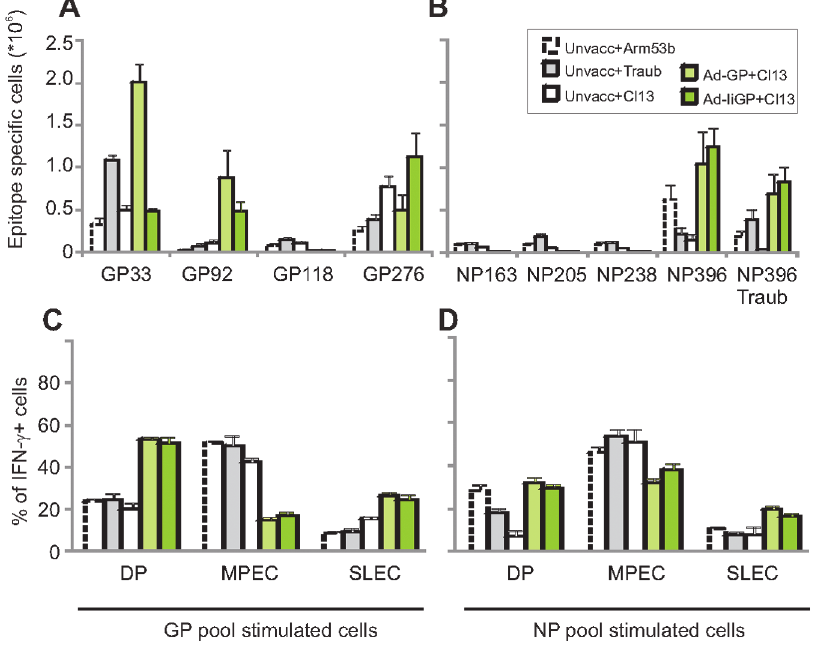
Fig 4. Comparison of vaccine attenuated Cl13 infection and primary infection with Cl13, Armstrong 53b or Traub strain of LCMV on the generation of memory CD8+ T cells. Cells from mice infected as indicated or vaccinated as indicated and then clone 13 challenged were stimulated with individual GP or NP peptides ( a-b ), or with a pool of GP ( c ) and NP ( d ) peptides 150 days after infection. The total number of splenic CD8+ T cells producing interferon- γ is shown in a-b . The percentage of cell producing interferon- γ in response to GP ( c ) or NP ( d ) peptides, that also expressed certain combinations of CD127 and KLRG-1 are depicted, CD127+/KLRG1+ (DP), CD127+/KLRG1- (MPEC) and CD127-/KLRG1+ (SLEC)). Shown are mean +SEM of 4 – 5 mice per